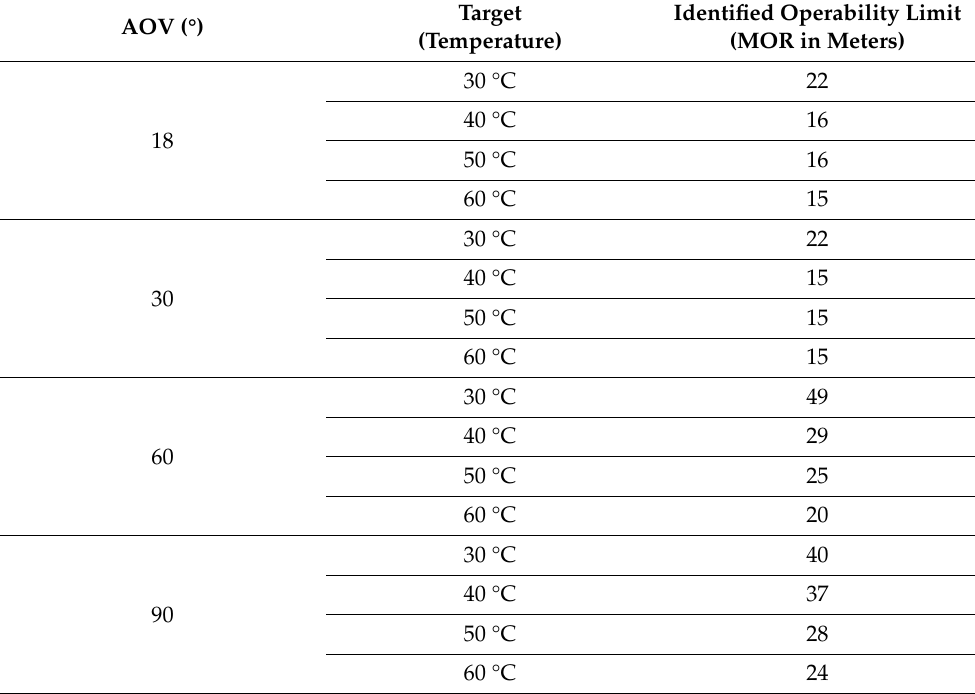
Table 3. Identification of operability